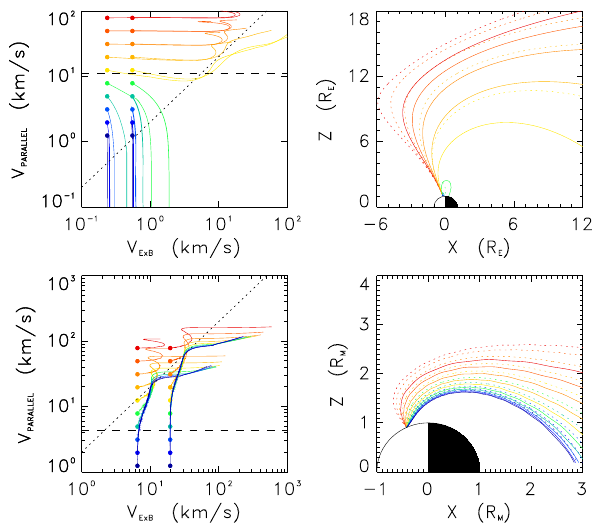
Fig. 3. (Left) Parallel speed of (top) O + ions at Earth and (bottom) Na + ions at Mercury as a function of E × B drift speed. (Right) Cor- responding trajectories in the noon-midnight meridian plane. The test ions are launched into the magnetosphere with different (color- coded) initial speeds. Two distinct cross-polar cap potential drops ( 18 ) are considered: (top) 60kV and 120kV, (bottom) 10kV and 30kV. Closed circles in the left panels show the initial parallel ion speeds and E × B drift speeds (of ∼ 250ms − 1 and ∼ 500ms − 1 at Earth, and ∼ 6.5kms − 1 and ∼ 20kms − 1 at Mercury). Dotted lines in the right panels show the ion trajectories achieved with the lower of the two 18